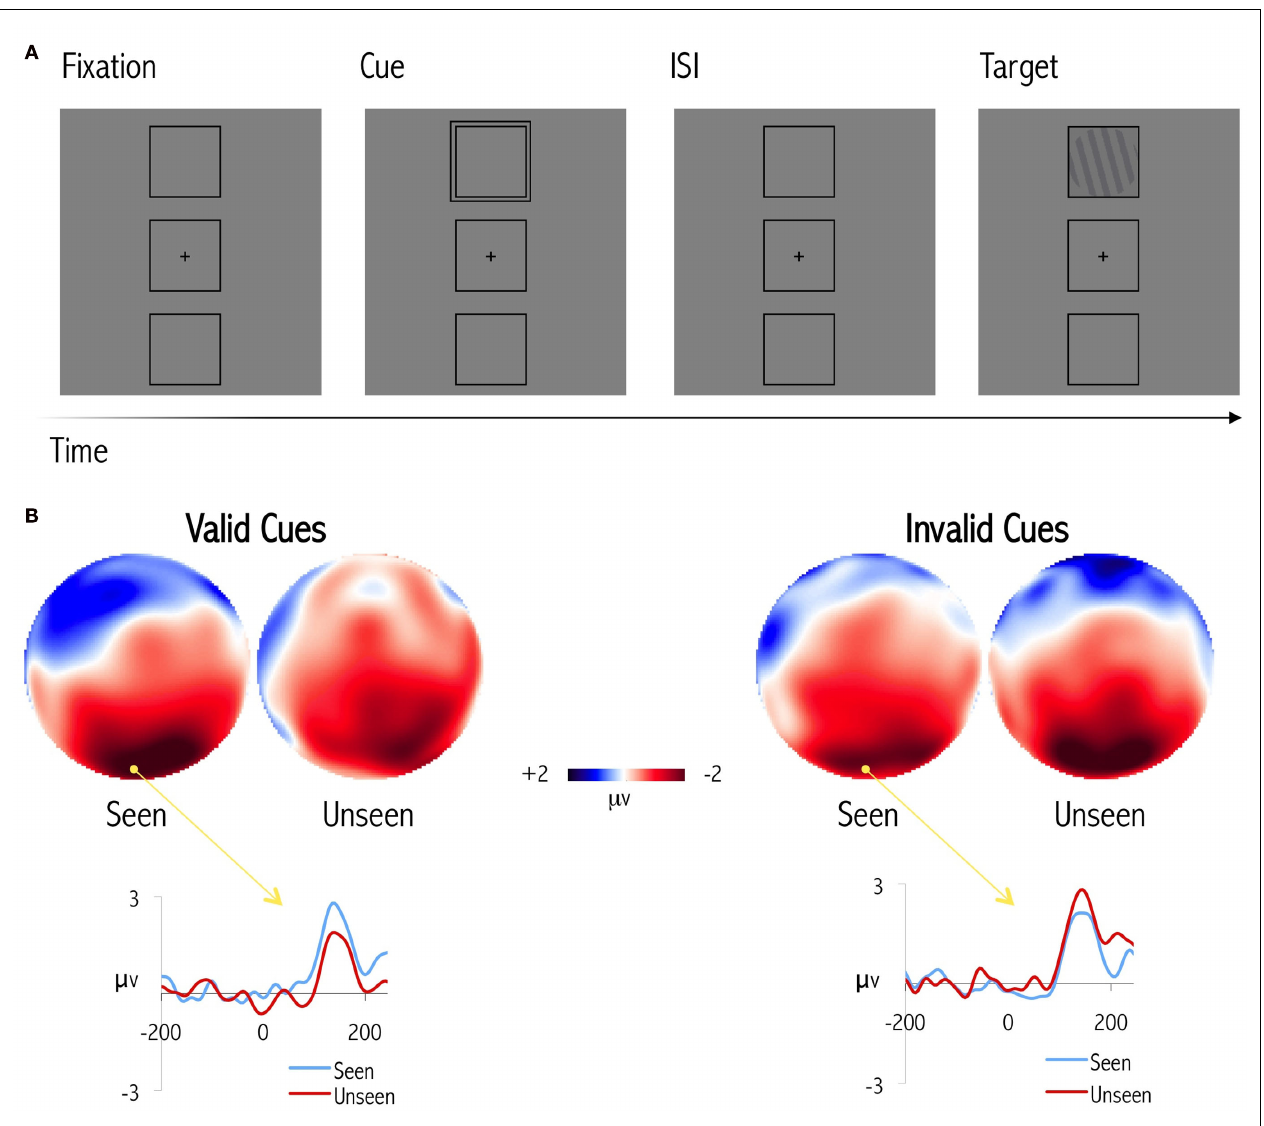
invalid cues, leading to seen and unseen reports (adapted from Chica et al., 2010).The figure shows that for valid cues, P100 is larger for subsequently seen than unseen targets; for invalid cues, P100 is instead larger for subsequently unseen than seen